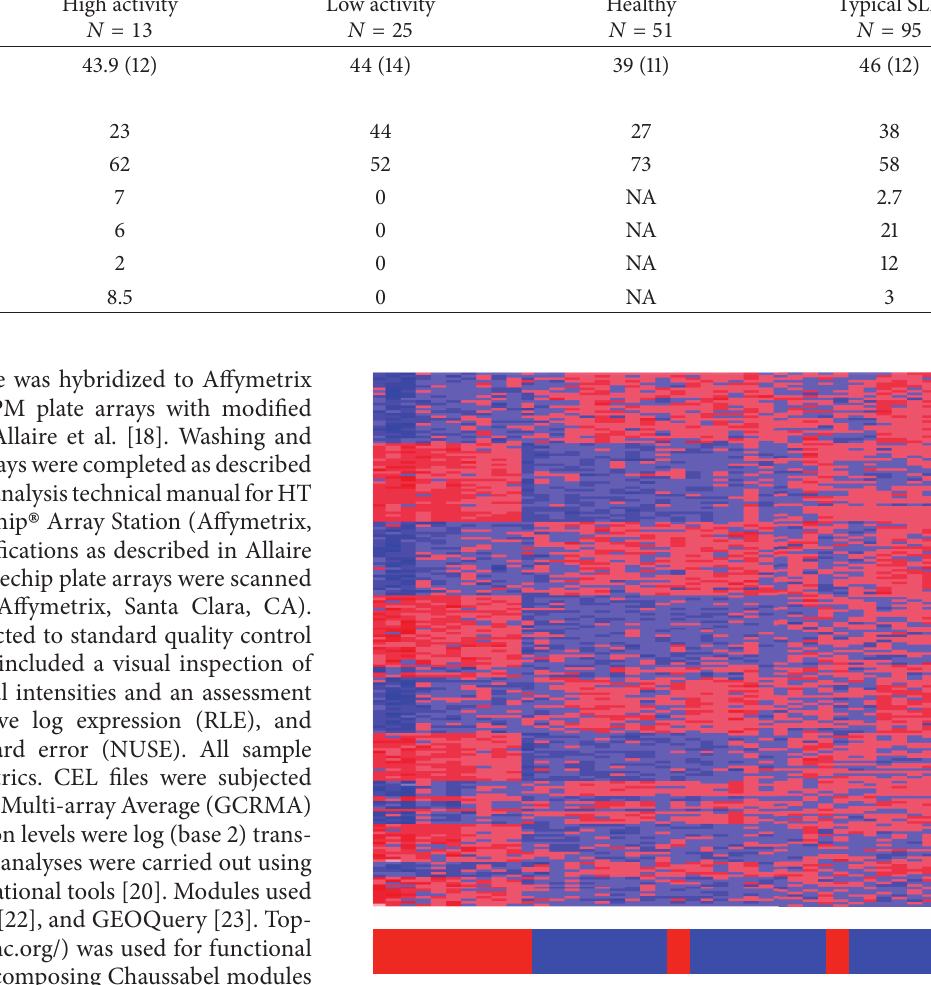
Figure1:HeatmapofSLEpatients.Hierarchicalclusteringseparates patientswithhighdiseaseactivityfromthosewithnoclinicaldisease activity. The red bars along the bottom indicate patients with high